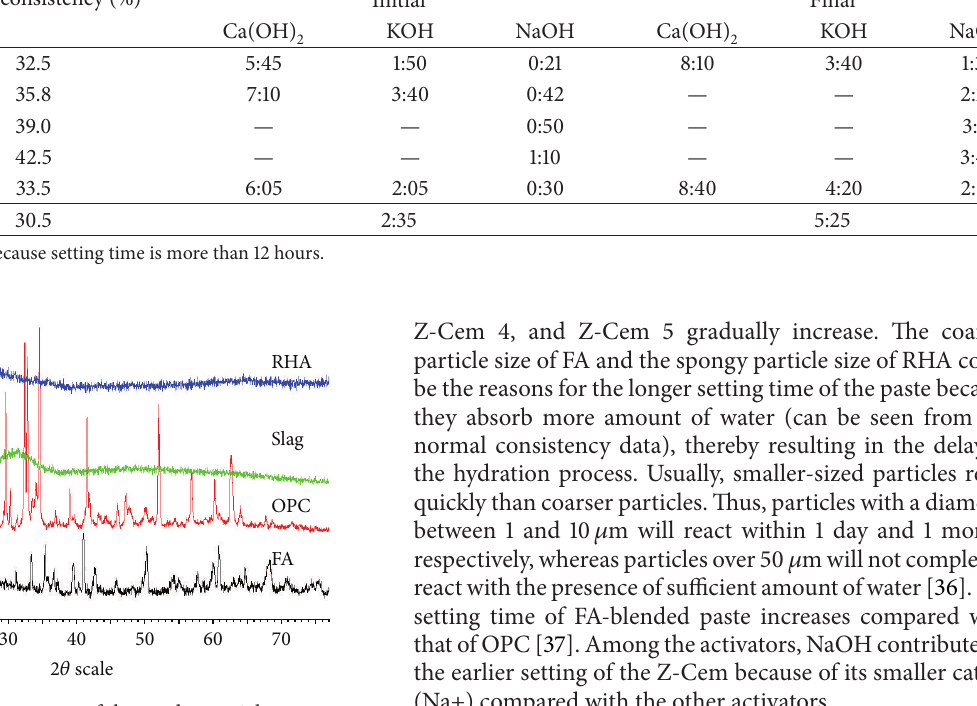
Figure 2: XRD patterns of the used